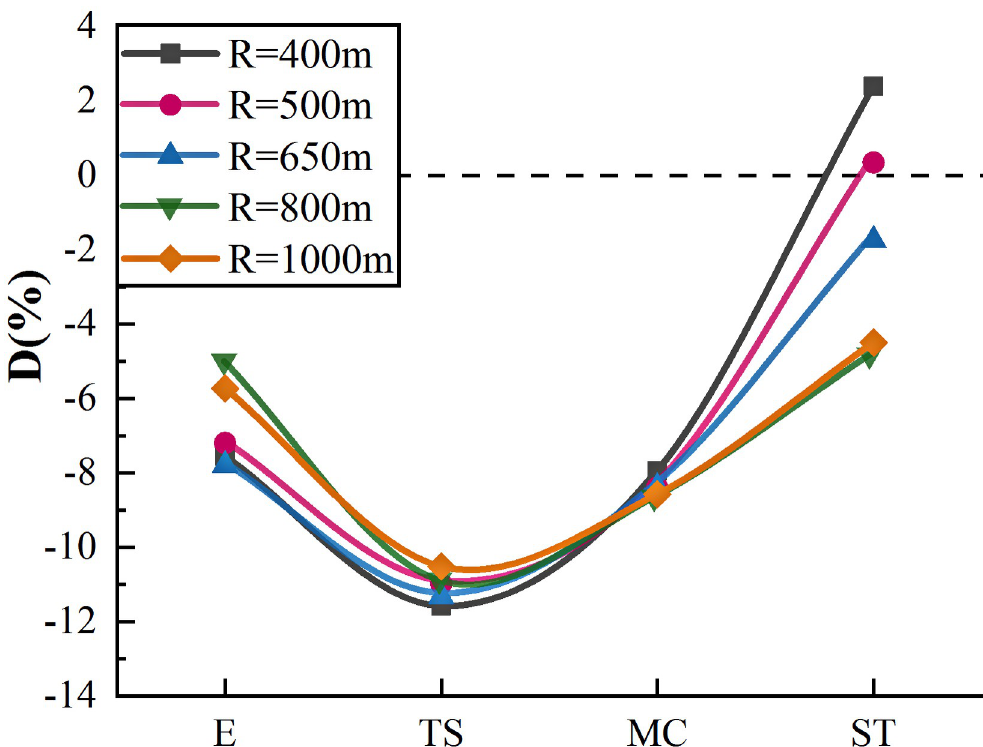
Fig 13. Perceived speed deviation diagram of single